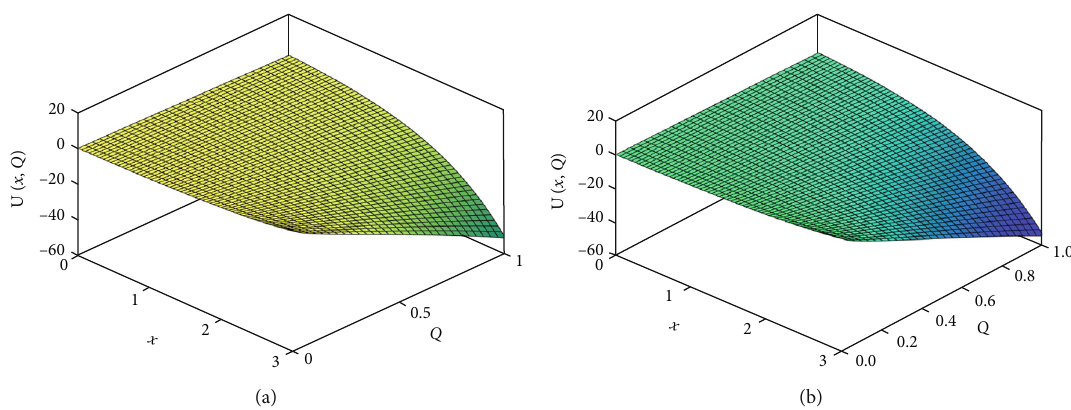
Figure 2: Three-dimensional illustration of the approximate solution via CFD of Example 1 when (a) δ = 0 : 9 and δ = 0 : 8 :